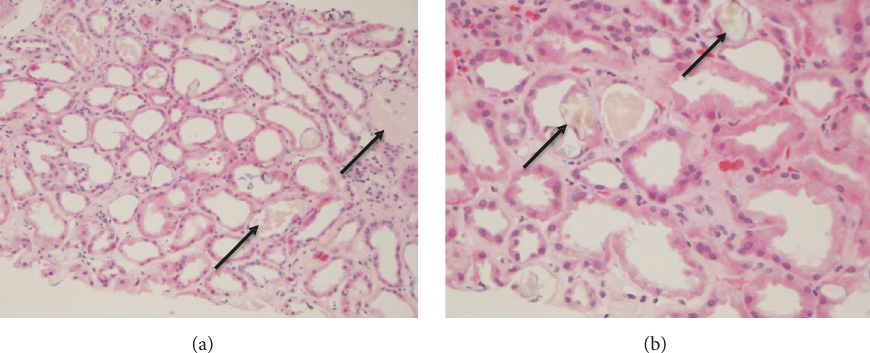
Figure 1: (a) Renal biopsy lightmicroscopy (stain, hematoxylinand eosin) showing renaltubules with severeacuteinjury,epithelial flattening and diffuse deposition of oxalate crystals (arrow) within the cortex and medulla. (b) Renal tubules containing numerous oxalate crystals